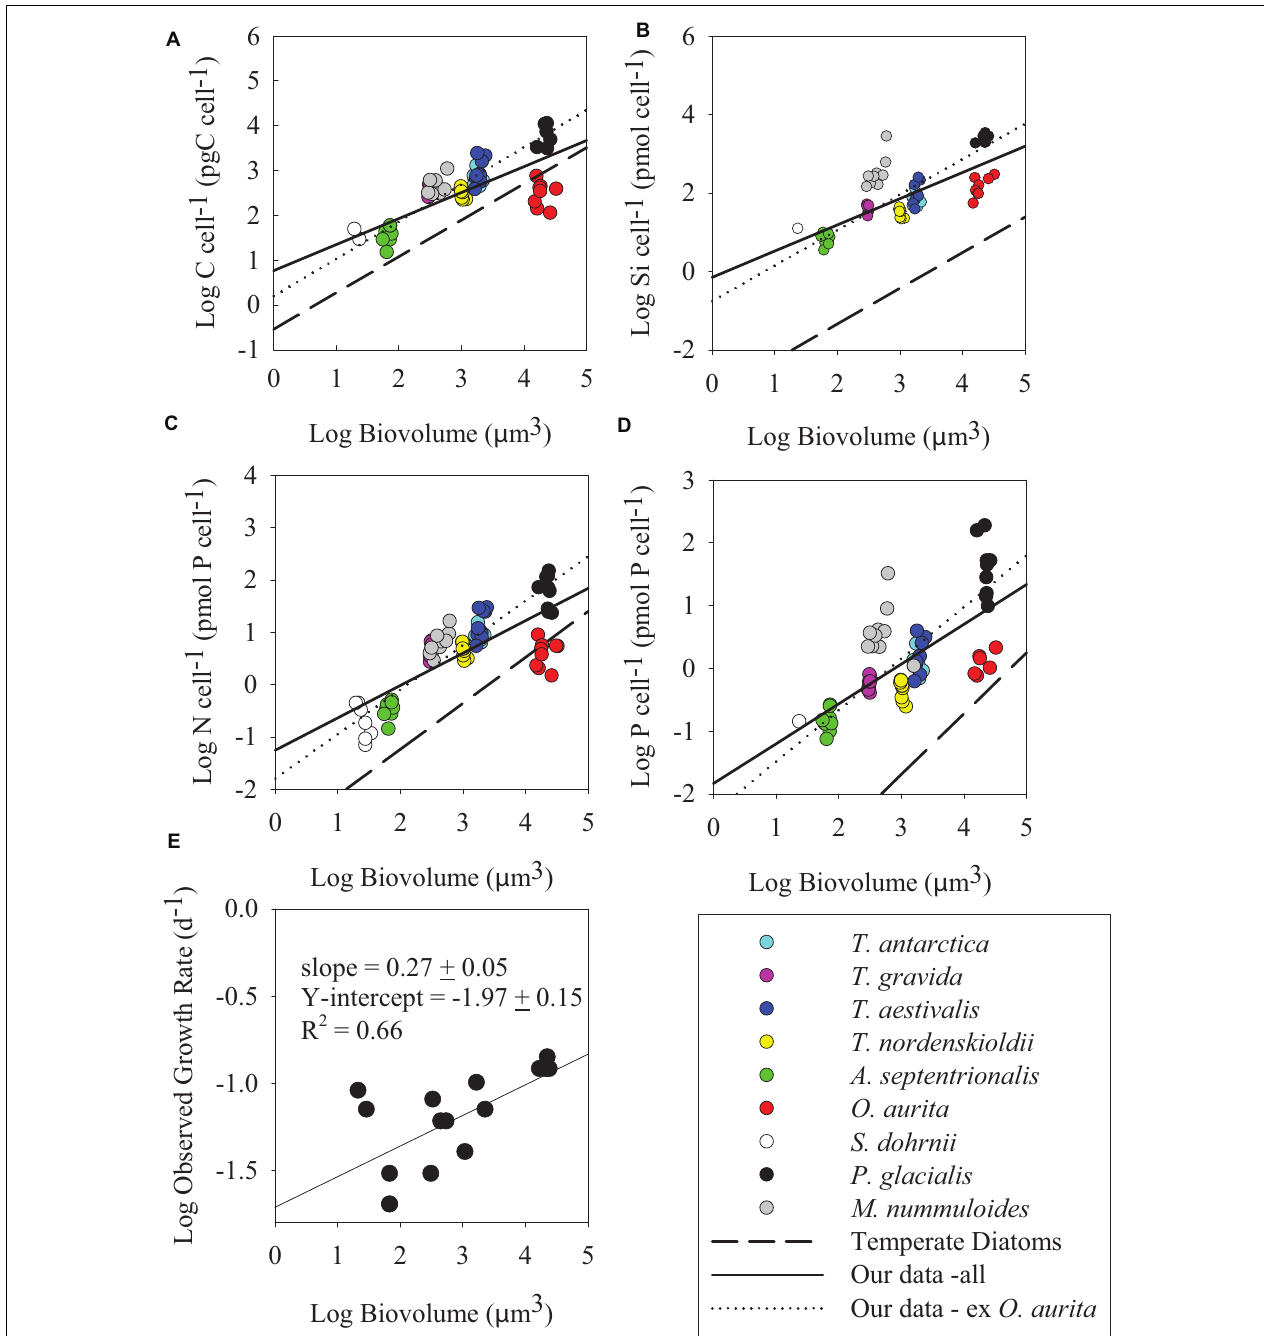
FIGURE 2 | Log–log plots of cell element quotas (pmol cell − 1 ) versus cell biovolume ( µ m 3 ) at the mid-exponential sampling point; (A) carbon quota, (B) silicon quota, (C) nitrogen quota, and (D) phosphorus quota. All replicates for all treatments are presented. Solid line represents best fit linear regression of all our data, while dotted line represents best fit linear regression of our data excluding O. aurita (see section “Discussion”). Dashed line represents a commonly cited allometric fit for temperate diatoms. C cell − 1 : Menden-Deuer and Lessard (2000); Si cell − 1 : Conley et al. (1989); N cell − 1 and P cell − 1 : Edwards et al. (2012). (E) Log observed growth rate versus cell